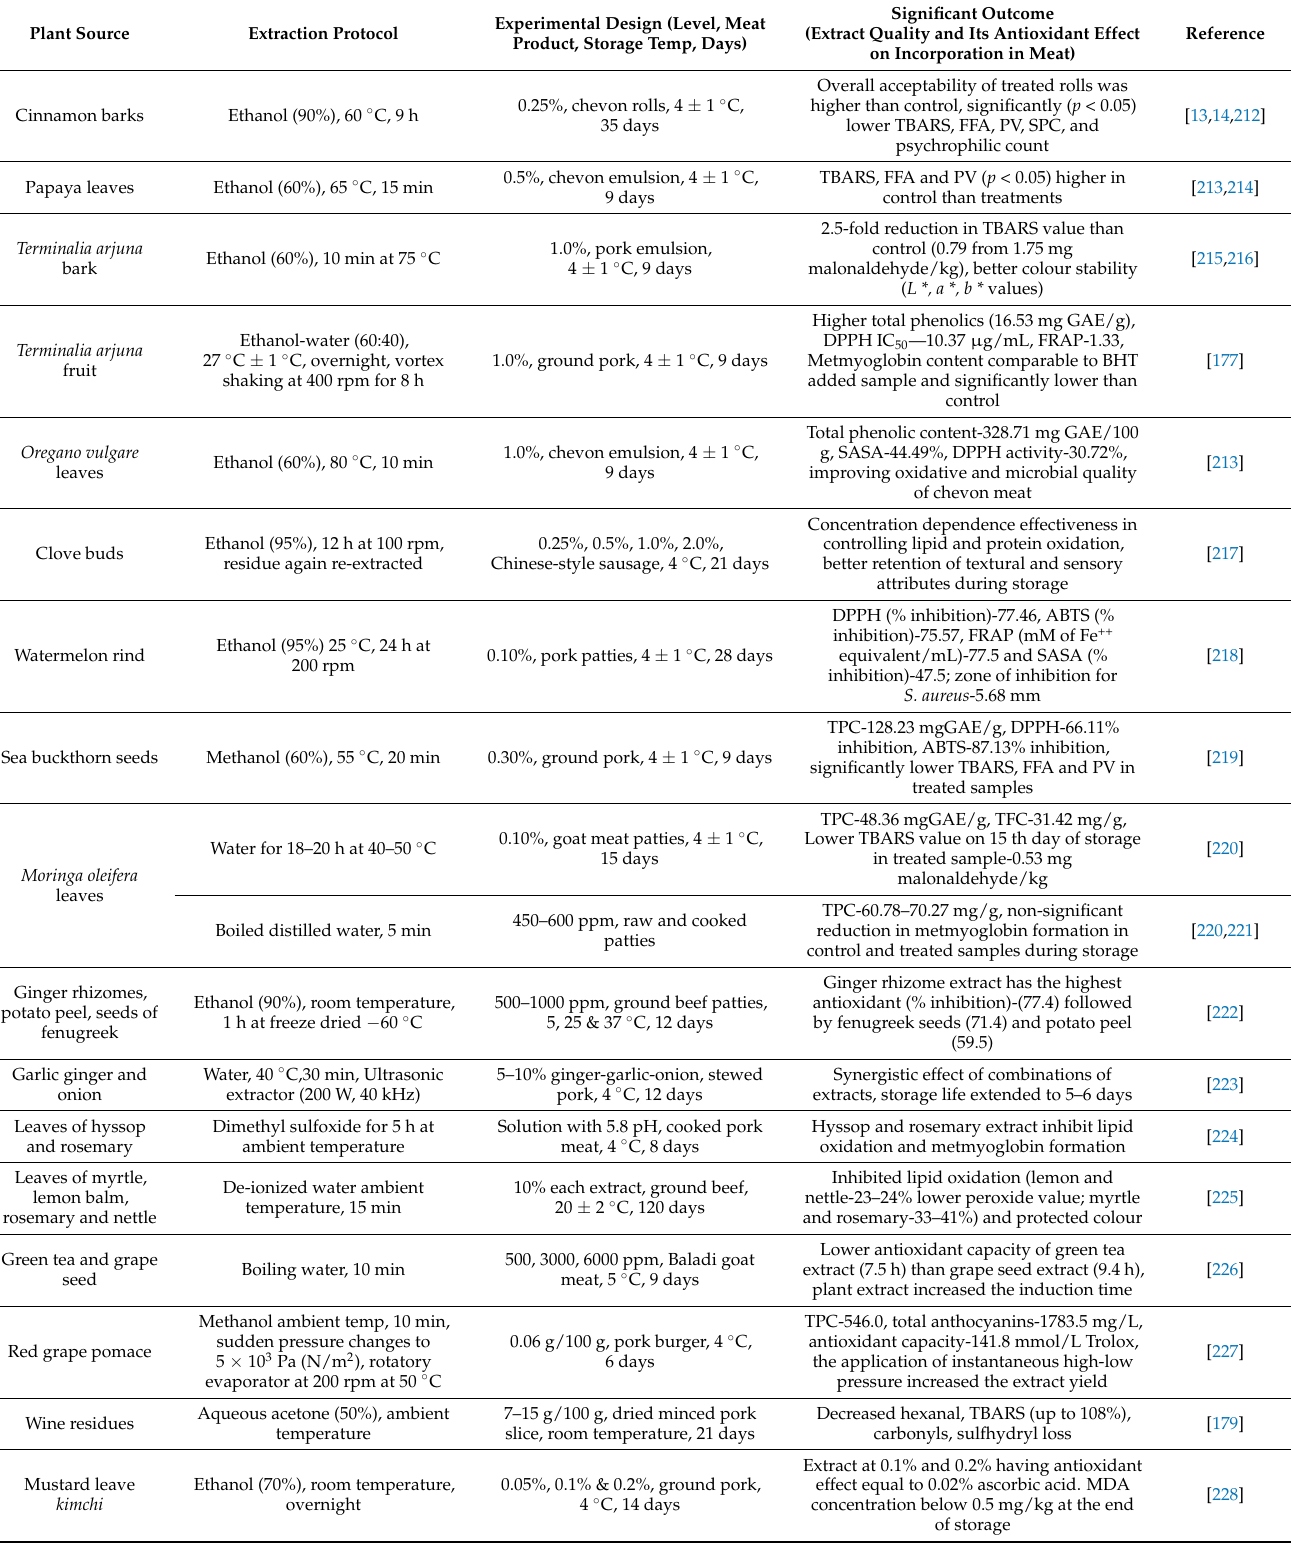
Table 9. Plant extracts as a natural antioxidant in